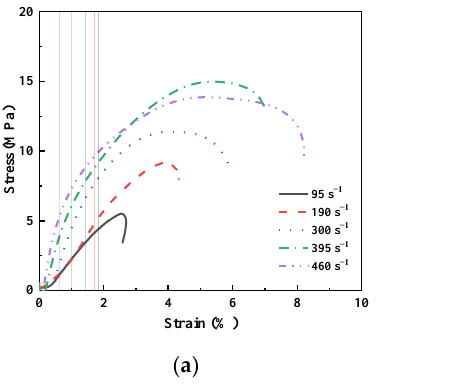
Figure 15. Relative crushing rate of sand specimens for different moisture contents.